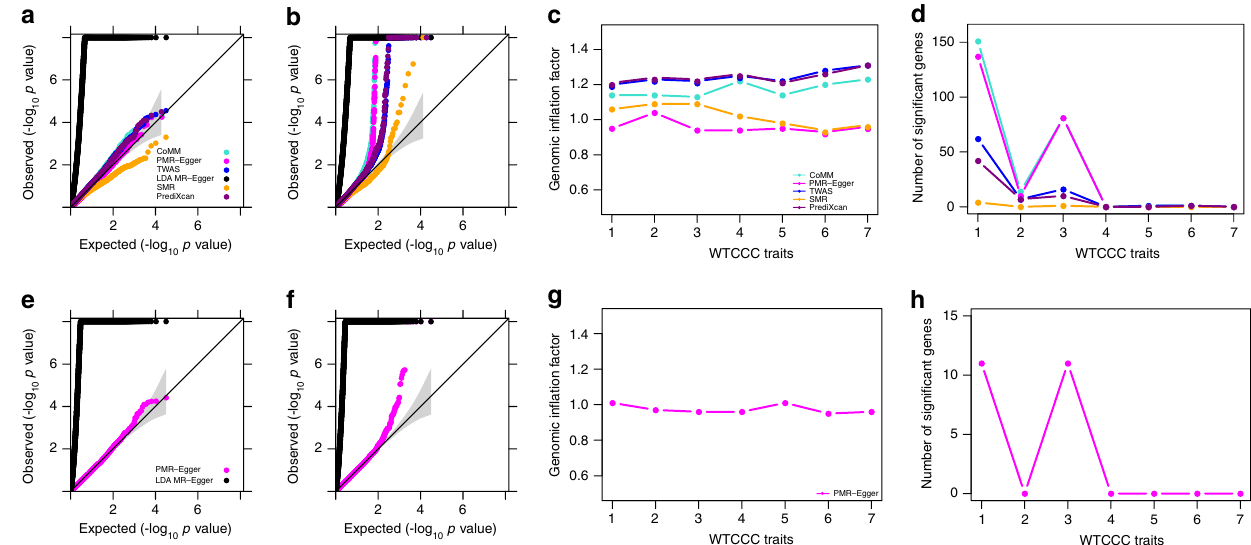
Fig. 4 TWAS analysis results by different methods for WTCCC traits. Compared methods include CoMM (turquoise), PMR-Egger (magenta), TWAS (blue), LDA MR-Egger (black), SMR (orange), and PrediXcan (purple). a Quantile – quantile plot of − log10 p -values from different methods for testing the causal effect for an exemplary trait BD. b Quantile – quantile plot of − log10 p -values from different methods for testing the causal effect for another exemplary trait T1D. c Genomic in fl ation factor for testing the causal effect for each of the seven traits by different methods. d Number of causal genes identi fi ed for each of the seven traits by different methods. e Quantile – quantile plot of − log10 p -values from different methods for testing the horizontal pleiotropic effect for an exemplary trait BD. f Quantile – quantile plot of − log10 p -values from different methods for testing the horizontal pleiotropic effect for another exemplary trait T1D. g Genomic in fl ation factor for testing the horizontal pleiotropic effect for each of the seven traits by different methods. h Number of genes identi fi ed to have signi fi cant horizontal pleiotropic effect for each of the 7 traits by different methods. For c , d , g , h , the number on the x axis represents seven traits in order: T1D, CD, RA, BD, T2D, CAD, HT.